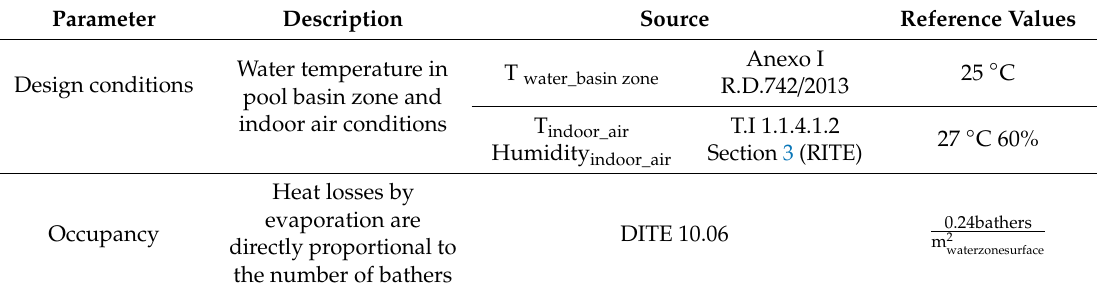
Table A7. Heat load for heated pools.